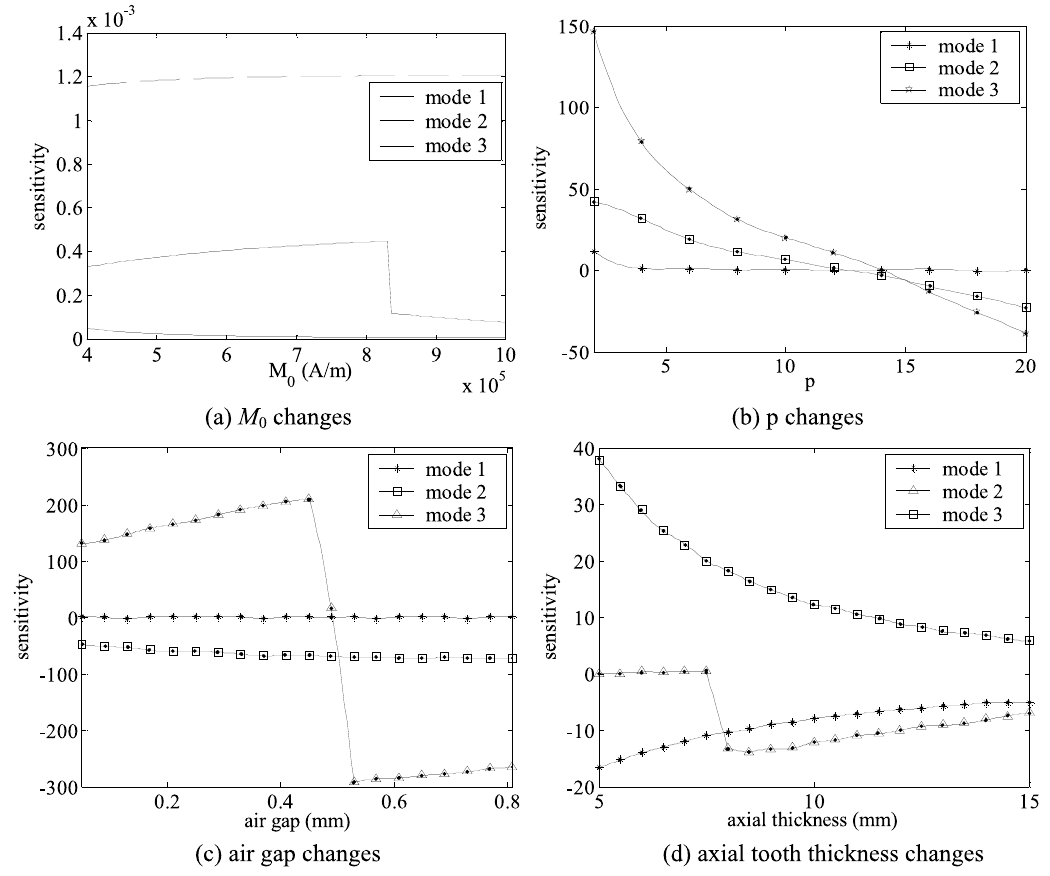
Fig. 12. Sensitivity to the system parameters for the planet